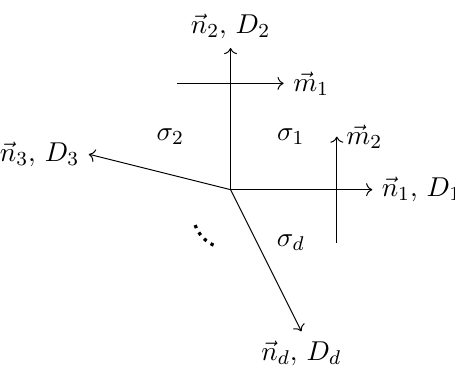
Figure 1 . A toric fan for a two-dimensional complex